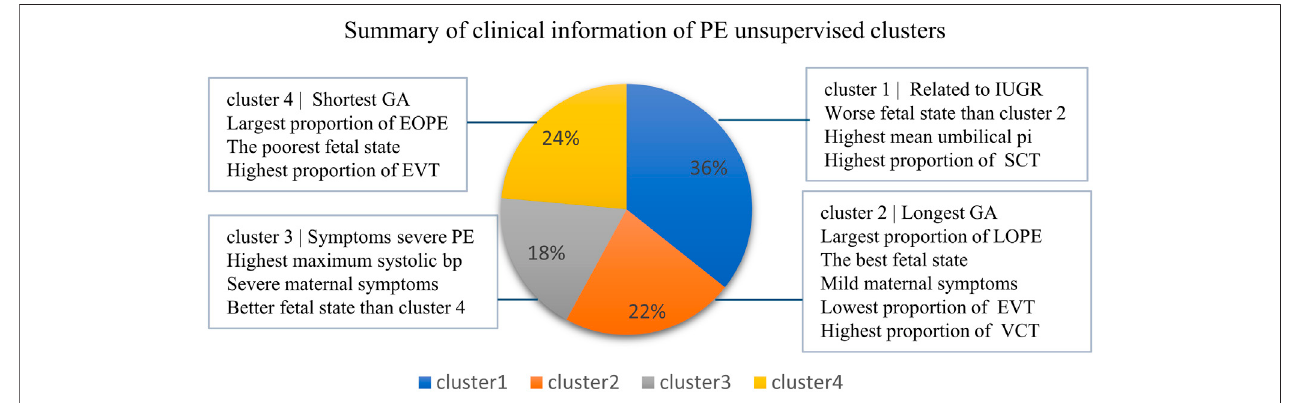
FIGURE 7 | Information overview of four clusters of PE. The sample fractions of the four clusters, respectively, accounted for 36%, 22%, 18%, and 24%.